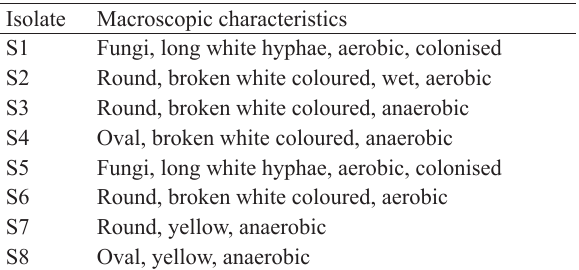
Table 1 Treatment factors Types of yeast isolates